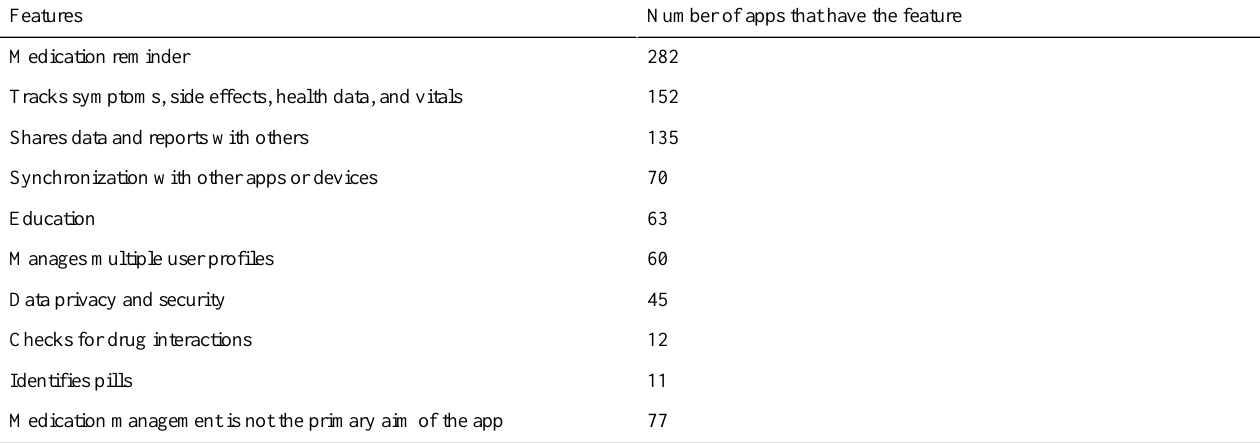
Table 3. The most prevalent features of the mobile apps for medication management.